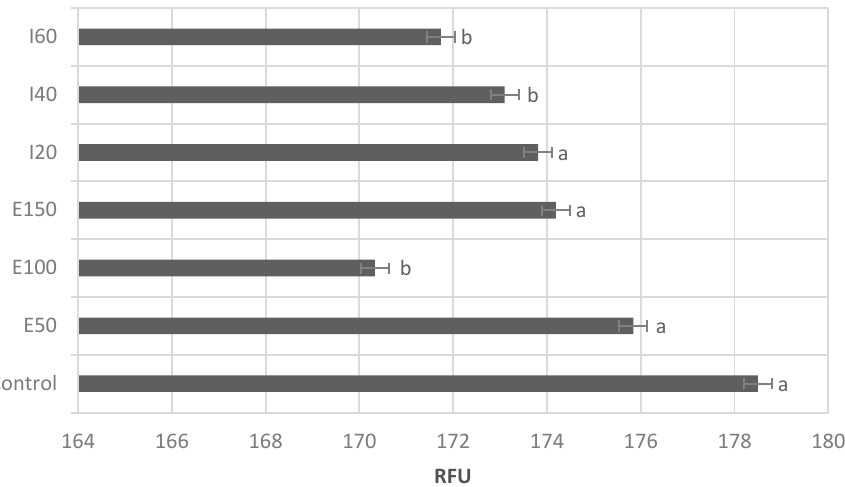
Figure 3. Reactive oxygen species production of frozen-thawed canine semen. E50: ergothioneine at 50 µ M. E100: ergothioneine at 100 µ M. E150: ergothioneine at 150 µ M. I20: isoespintanol at 20 µ M. I40: isoespintanol at 40 µ M. I60: isoespintanol at 60 µ M. RFU: relative fluorescence units. Bars represent the mean ± standard error of the mean (SEM). Different letters (a, b) between bars indicate significant statistical difference ( p ≤ 0.05).